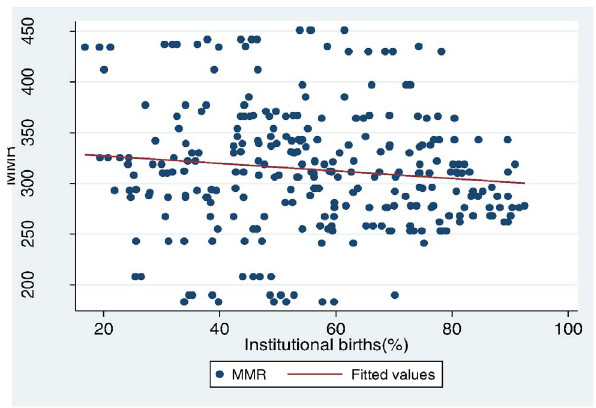
Figure.3. Scatter plot of MMR and proportion institutional births.